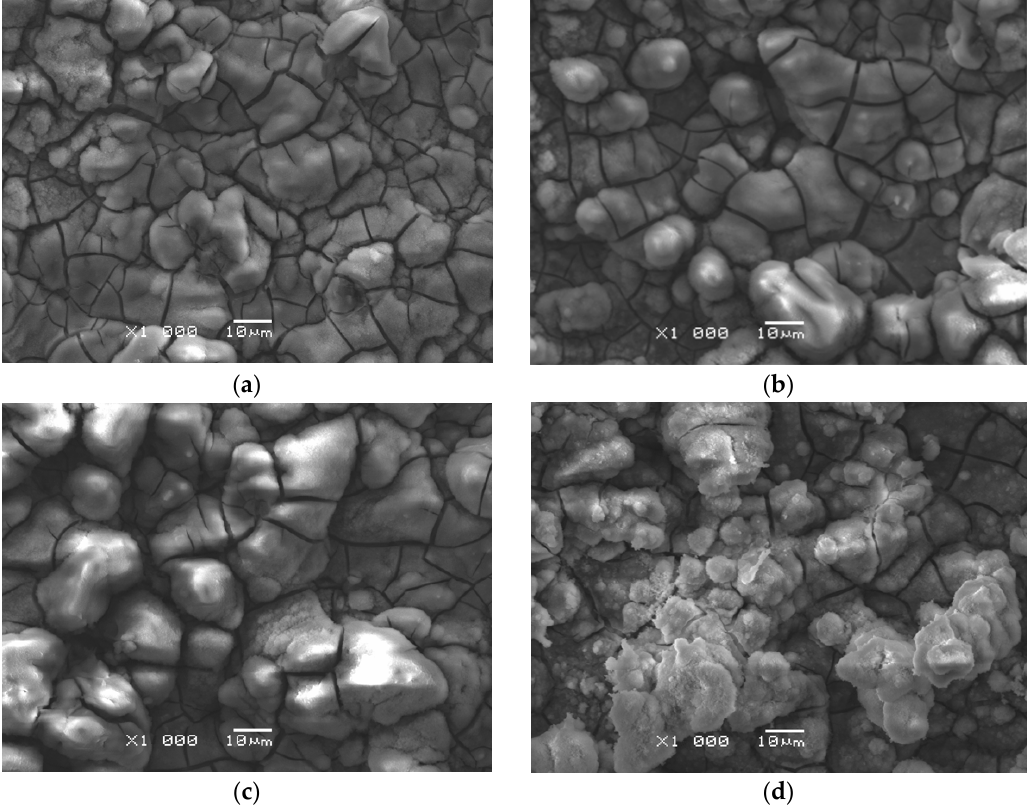
Figure 7. SEM image of the surface morphology for the CaP coating deposited at − 3 V for 30 min at: ( a ) 20 °C; ( b ) 30 °C; ( c ) 40 °C; ( d ) 70 °C.